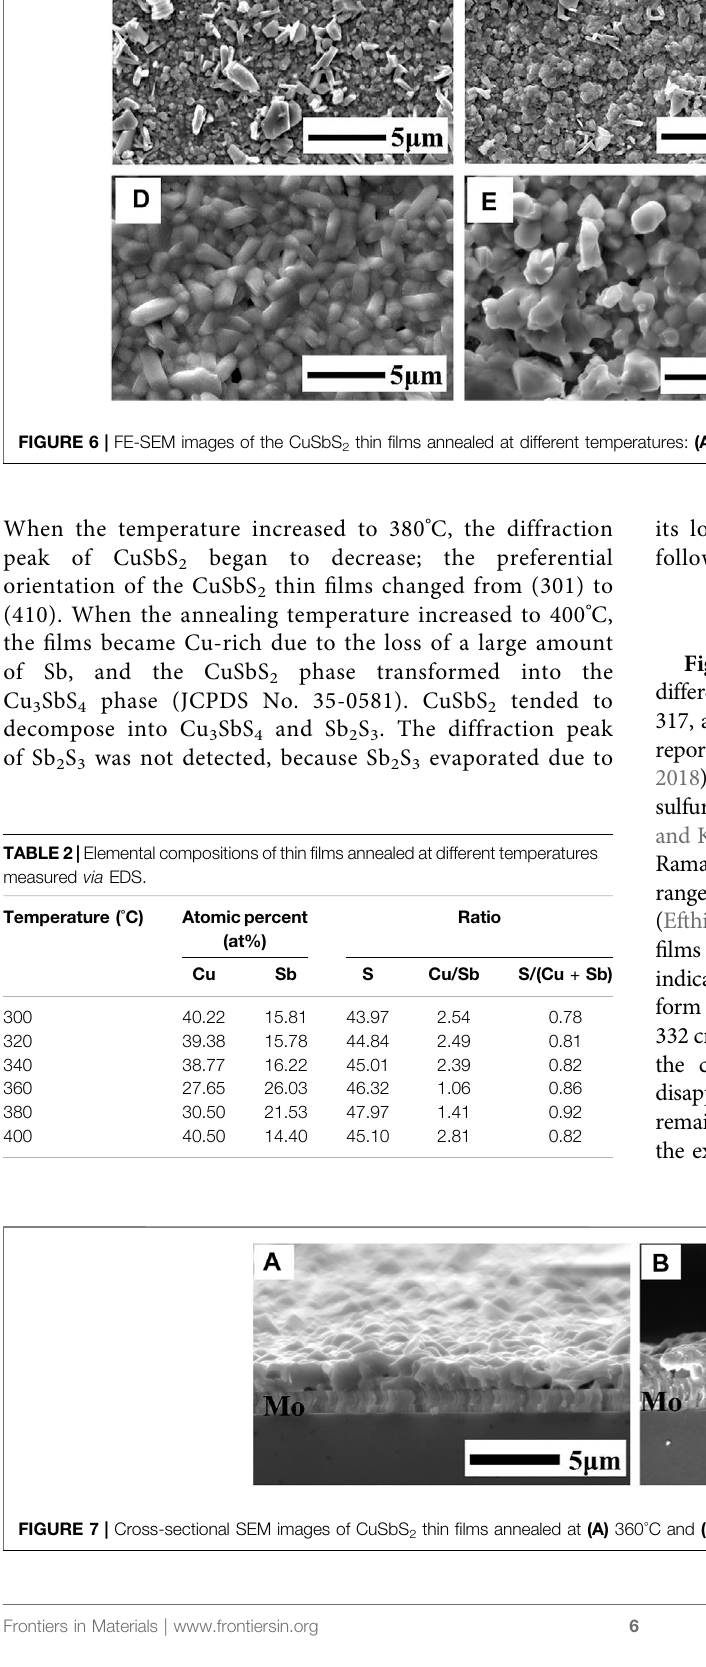
Frontiers in Materials |